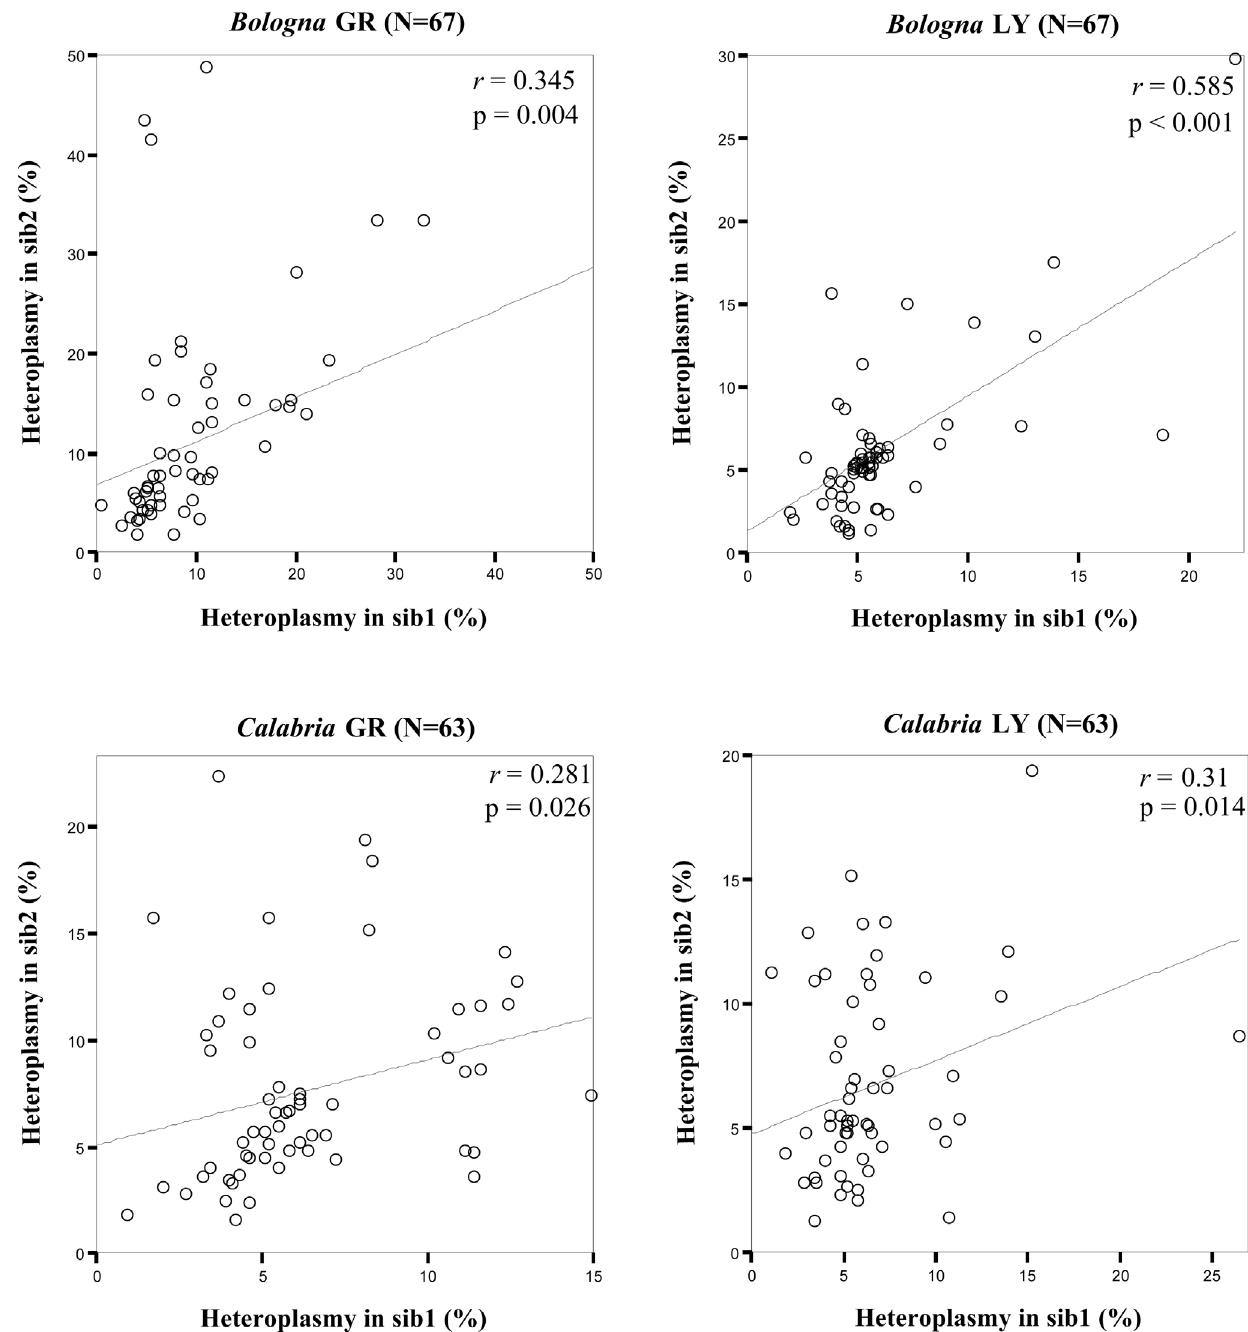
Figure 2. Correlation analyses in northern and southern Italian sib pairs. For each sample group regression lines and correlation coefficients (r) are shown. The p-values are obtained by 2-tailed Pearson test. Northern Italian: Bologna; southern Italian: Calabria.